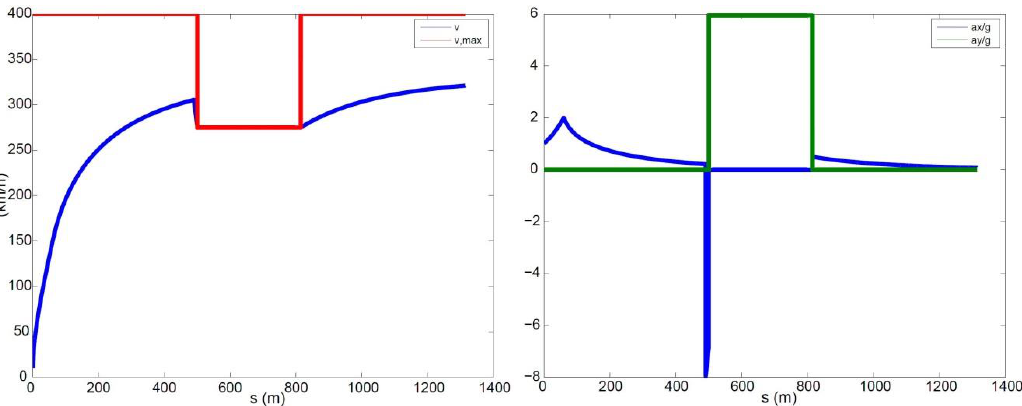
Figure 11. Straight lines and hairpin bend, no aerodynamics: (left) speed and (right) accelerations with respect to 𝑠 .